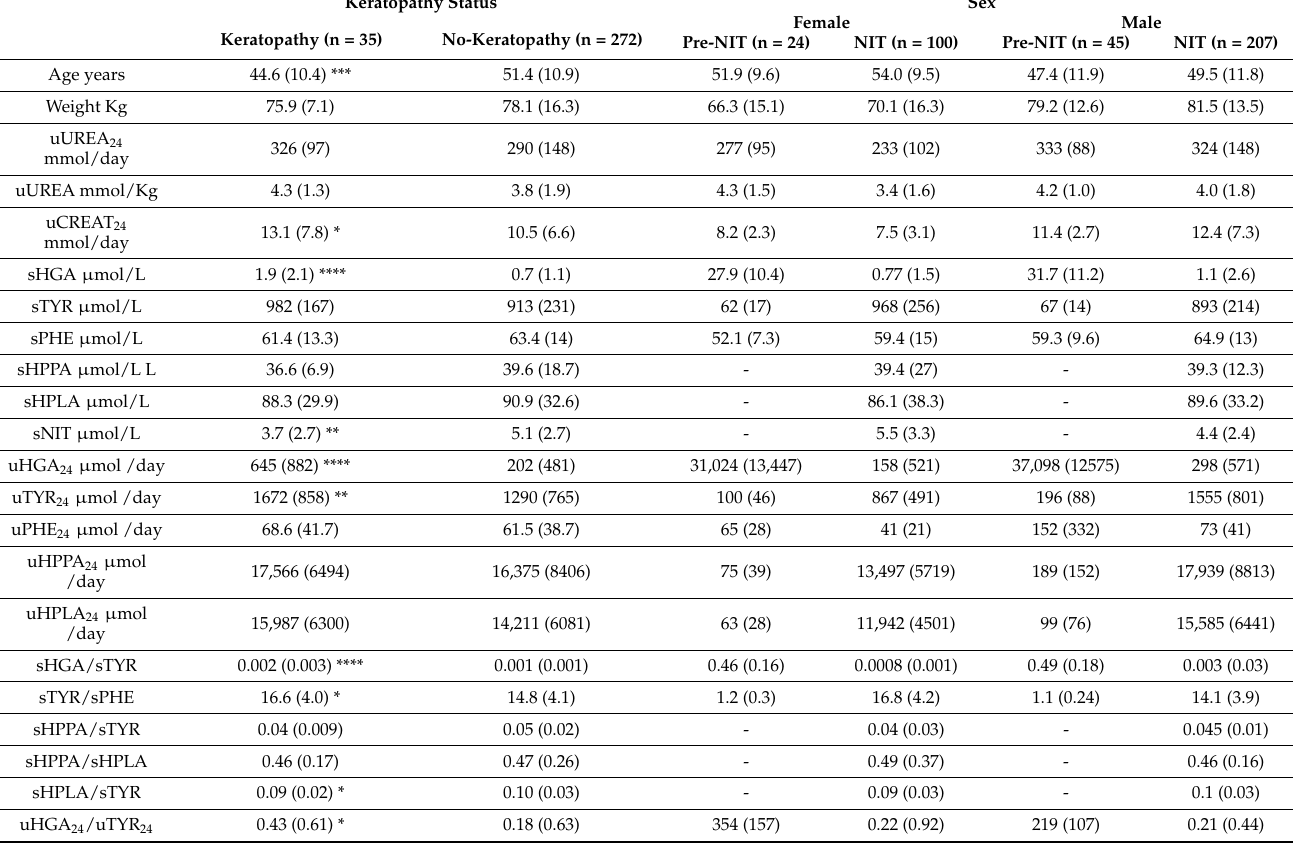
Table 1. Age, weight, uUREA 24 , uUREA 24 /kg, uCREAT 24 and measured metabolic data in NIT- treated AKU patients based on keratopathy status and